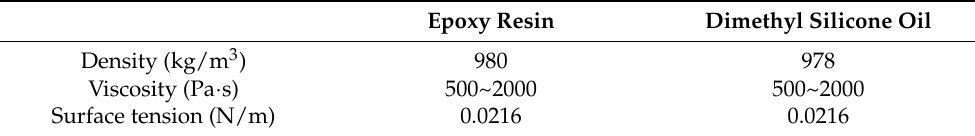
Table 1. Material properties.